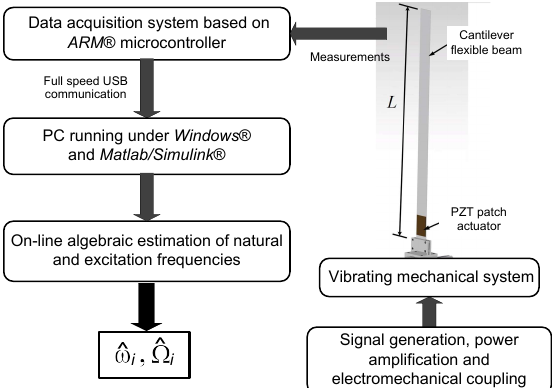
Figure 5. Schematic diagram of the signal generation and data acquisition system for online alge- braic